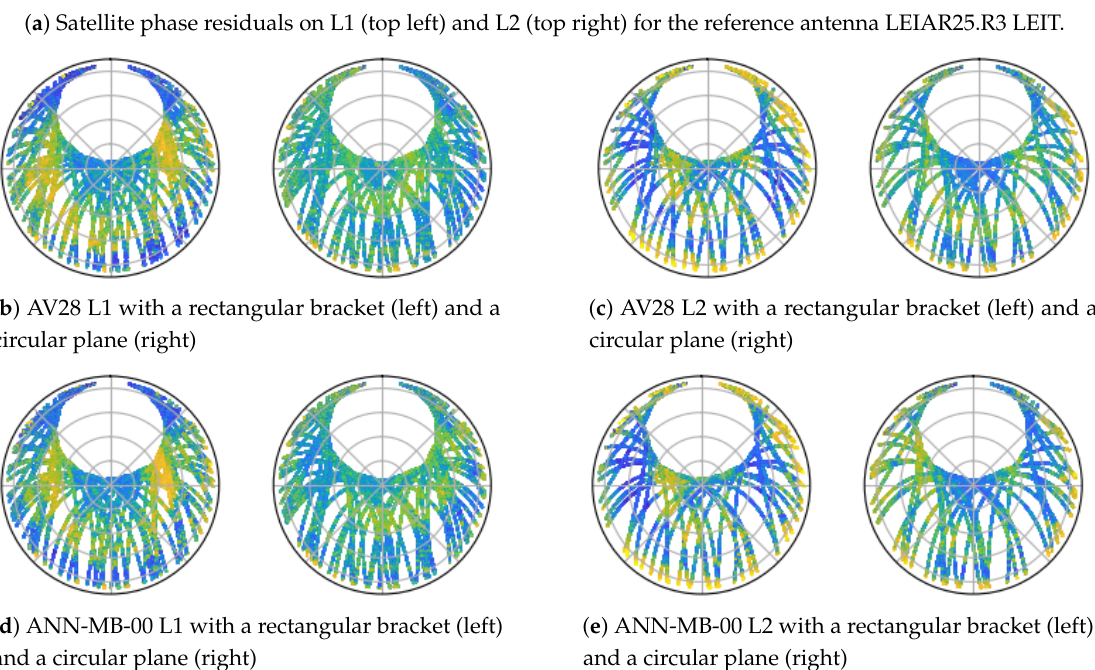
Figure 6. Satellite phase residuals on L1 (left) and L2 (right) for the selected antennas ( a ) LEIAR25.R3 LEIT (top frame), ( b ) AV28 L1, ( c ) AV28 L2, ( d ) ANN-MB-00 L1 and ( e ) ANN-MB-00 L2. The figures ( b – e ) depict on the left the phase residuals using a rectangular metallic bracket as base and on the right with a circular metallic plane of 10 cm